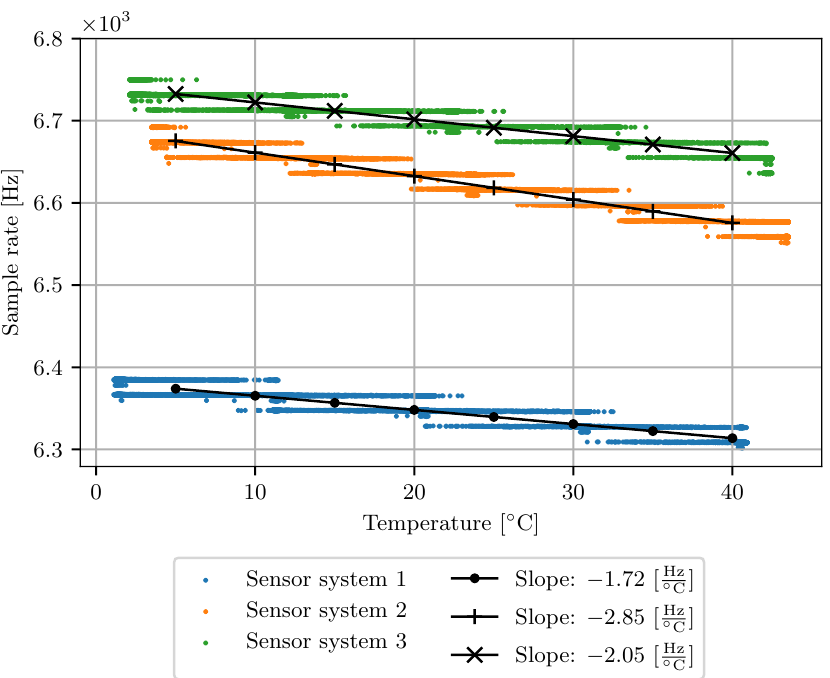
Figure 10. Temperature dependency of LSM6DSL inertial measurement units of three different devices. Slopes are given in Hz / ◦ C . Table 3. Measurements and data quality attributes for the Accelerometer Data Set. The column MLE explains the properties of the fitted distribution functions and the mean squared error (cid:101) obtained during the fit. The column fuzzy logic describes the properties of the fuzzy logic membership functions for the specified data quality